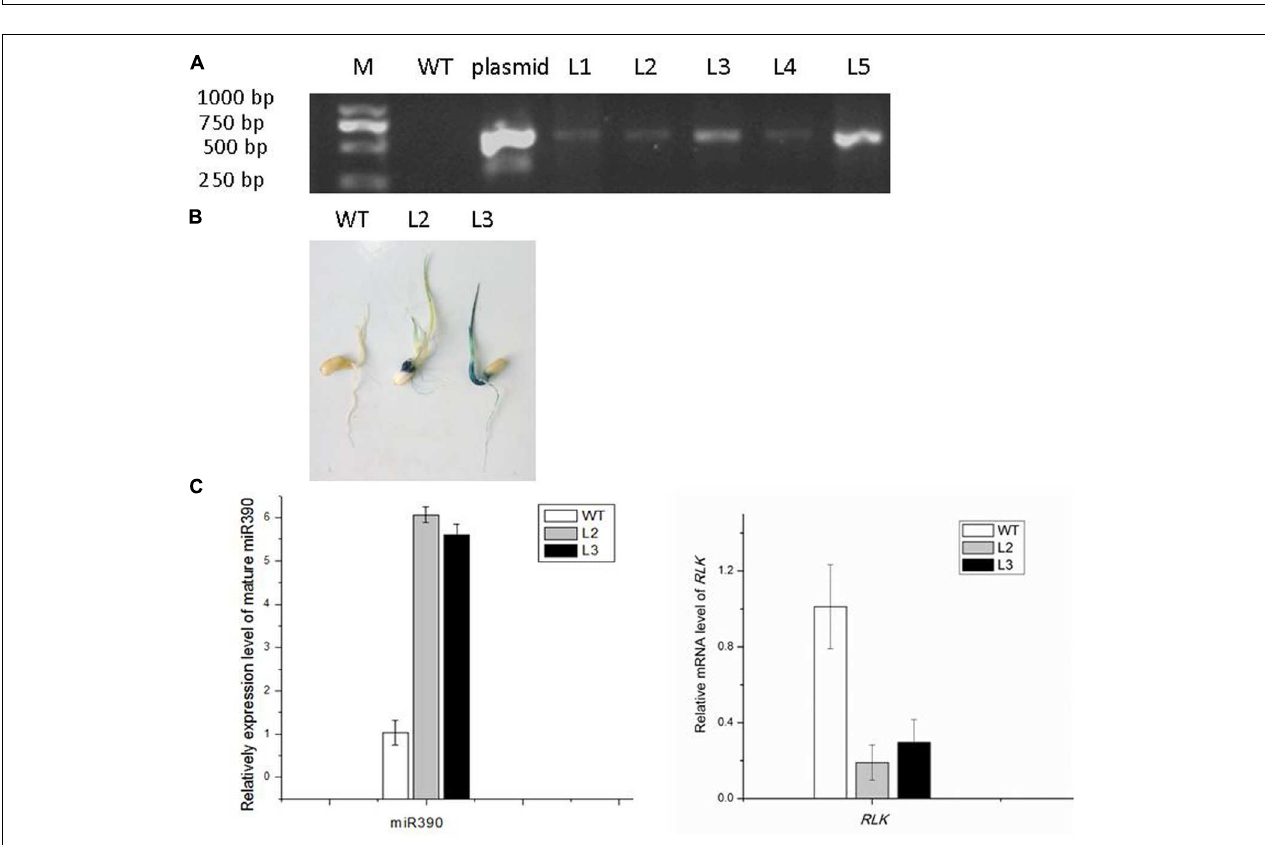
FIGURE 2 | Expression in plants of the vector of p1301- 35S:MIR390 . 35S, CaMV 35S promoter; NOS, nopaline synthase terminator; GUS , gene encoding β -glucuronidase; Hpt , gene encoding hygromycin phosphotransferase.